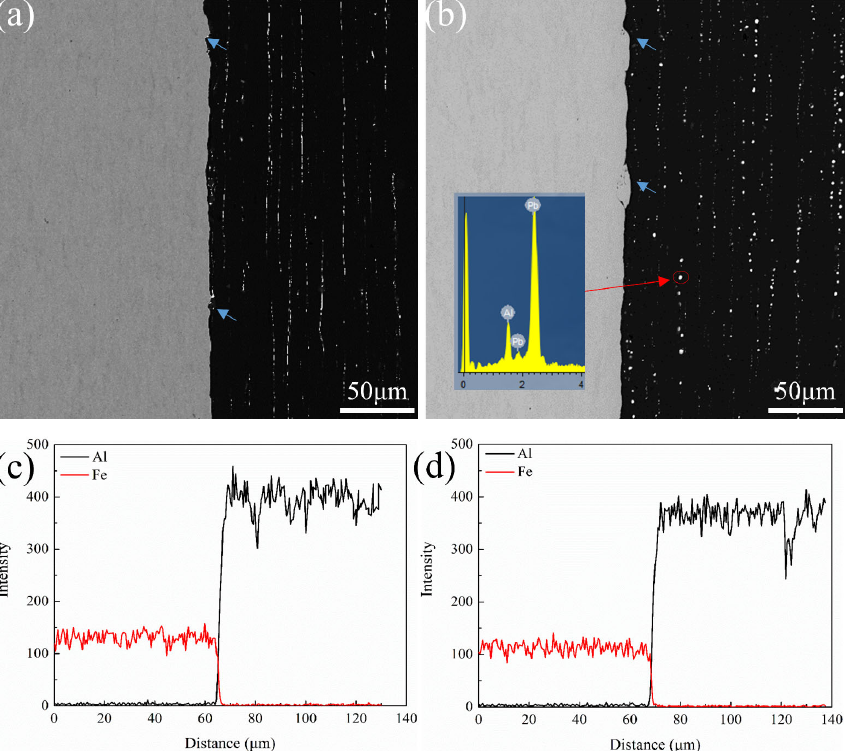
Figure 3. Interfacial images of Al/steel composites: ( a ) initial sample, ( b ) aged sample, ( c ) SEM-EDS line scan of ( a ), and ( d ) SEM-EDS line scan of ( b ).